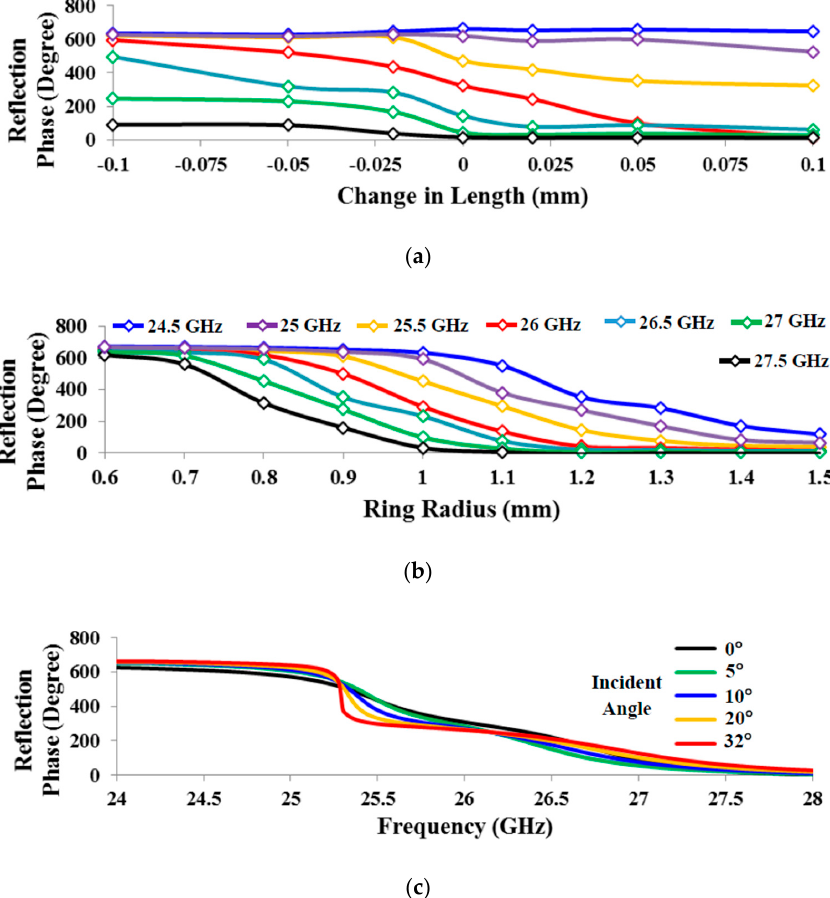
Figure 7. Reflection phase response of asymmetric patch element: ( a ) Measured with full ground; ( b ) Measured with ground ring slot; ( c ) Simulated with the different incident angle at 26 GHz.